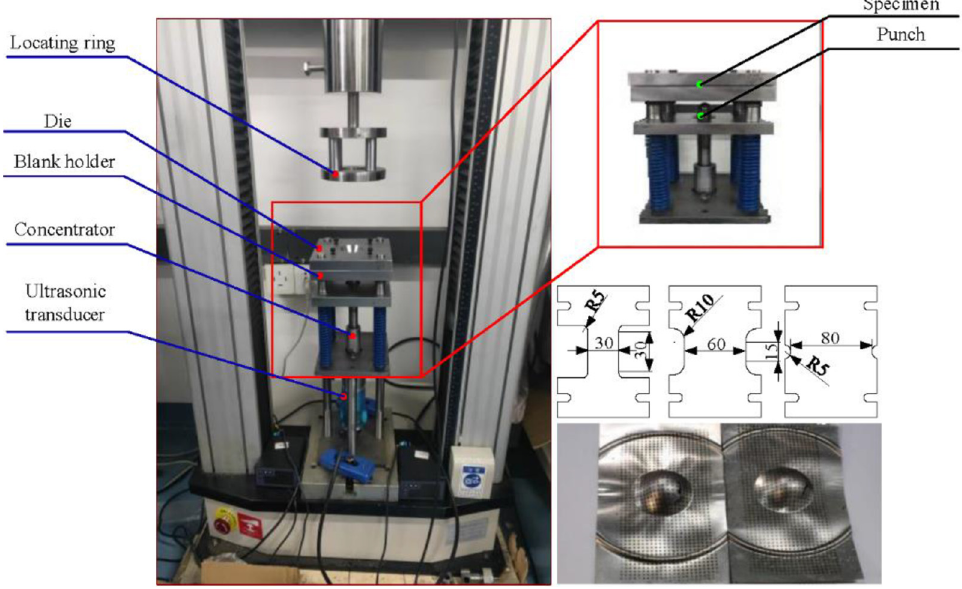
Fig. 8. The experimental device of bulging-forming based on ultrasonic